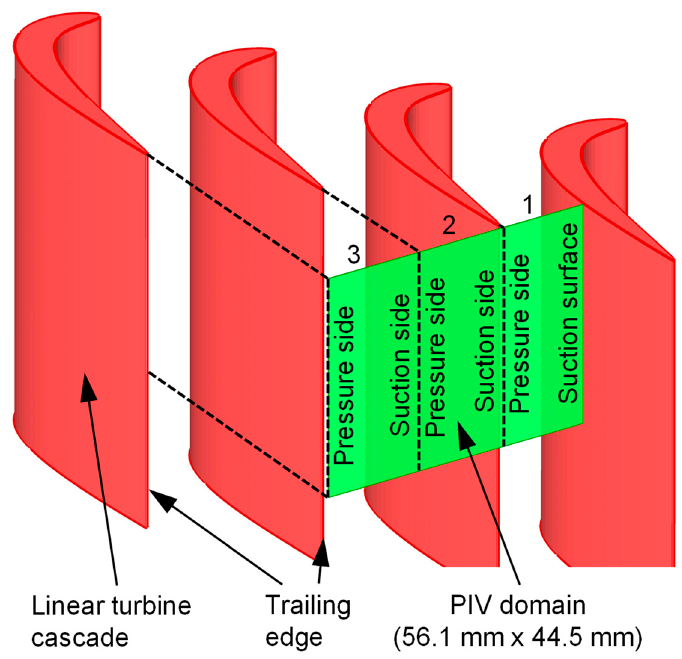
Figure 6. PIV measurement locations.